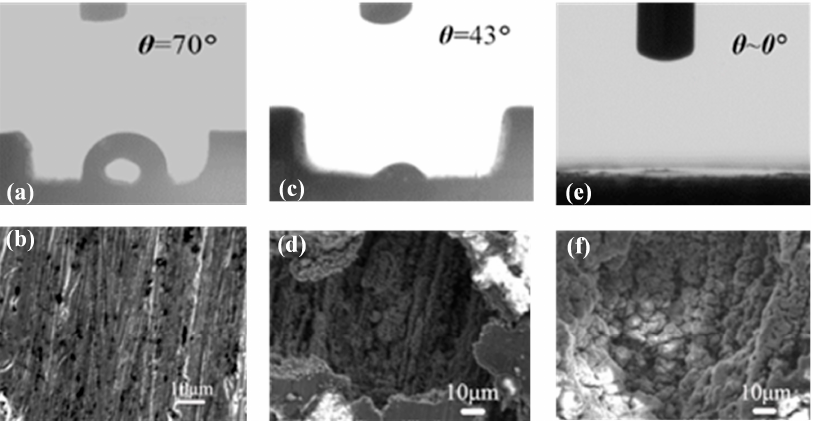
Figure 2. Contact angles and SEM images of different surfaces for ( a , b ) Untreated surface microchannel, ( c , d ) Hydrophilic microchannel, ( e , f ) Super-hydrophilic microchannel.